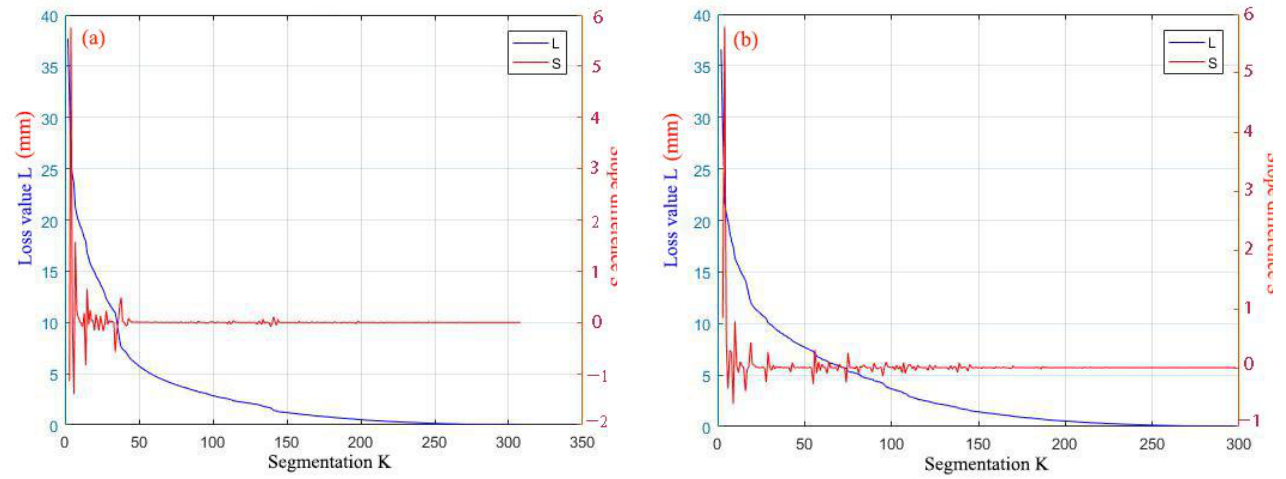
Figure 3. The results of Fisher optimal segmentation method under the different scales. ( a ) 100 grids; ( b ) 200 grids.